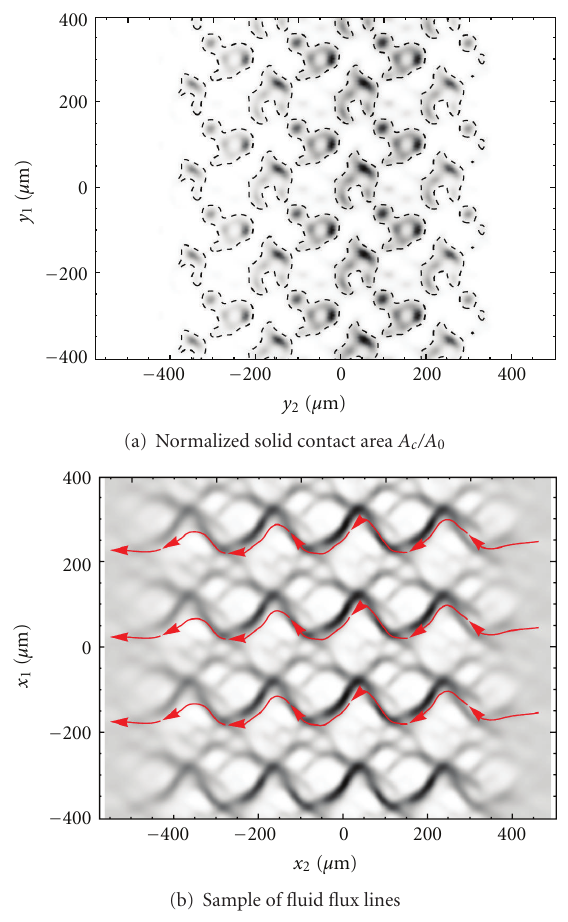
Figure 7: Static sealing e ff